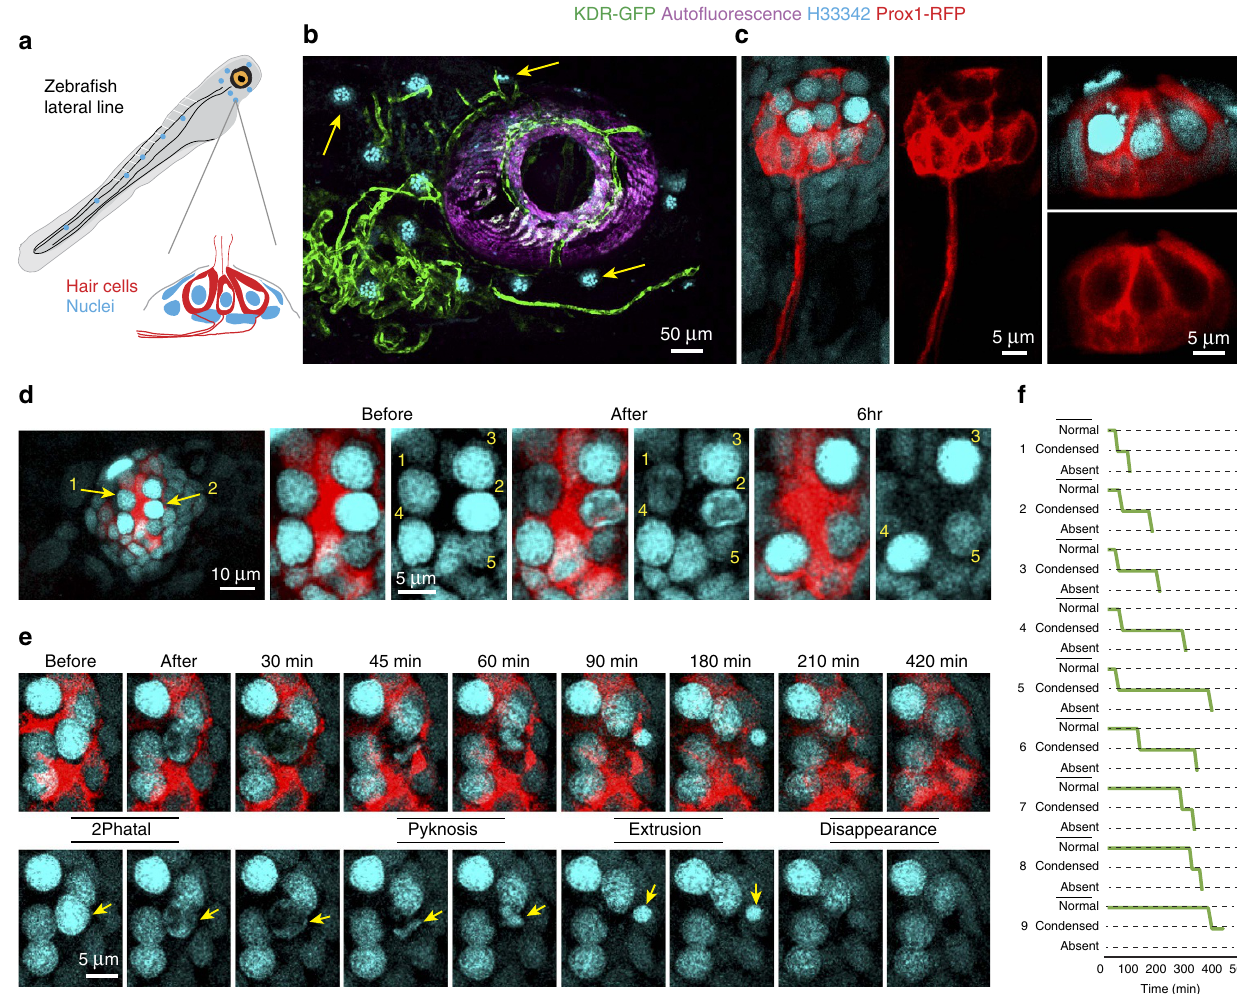
Figure 10 | Ablation of neuromast hair cells in the zebrafish lateral line. ( a ) Schematic depicting zebrafish neuromast hair cells of the lateral line labeled with H33342. ( b ) Low magnification live image of an anesthetized KDR -GFP transgenic zebrafish with the neuromasts labelled with H33342 (yellow arrows) and GFP-labelled vessels shown in green. ( c ) High-resolution live images of single neuromasts with hair cells labelled in the Prox1 -RFP transgenic line and cell nuclei labelled with H33342. ( d ) Two hair cells targeted for 2Phatal (yellow arrows) and imaged before, immediately after and at 6h showing disappearance of the targeted cells. Numbers designate single cells imaged over time. ( e ) Time-lapse sequence showing nuclear pyknosis, extrusion of the condensed nucleus and disappearance of the targeted cell (yellow arrows). ( f ) Traces showing the time course of the apoptotic progression for nine cells targeted for 2Phatal from three separate